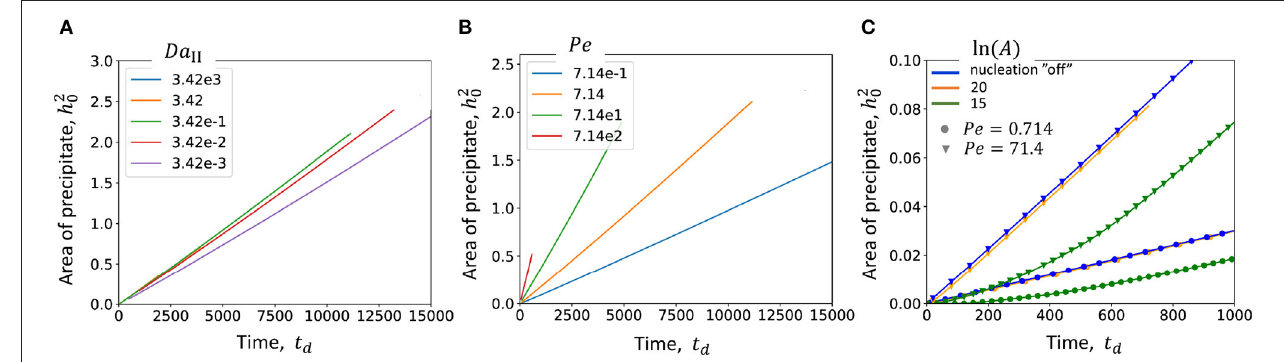
FIGURE 8 | Amount of precipitate vs. simulation time. (A) At different Da II numbers; (B) At different Pe numbers; (C) in case of nucleation is “off” (blue) and “on” at ln A = 20 (orange) and 15 (green) the dependencies are presented at Pe = 0.714 and Pe = 71.4, which corresponds to the data presented in Figure 8 .